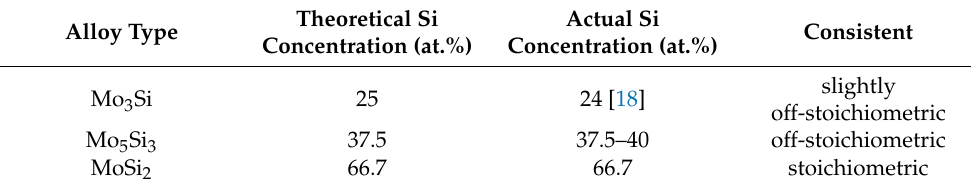
Figure 2. Mo-Si binary phase diagram [15]. Table 3. Mo-Si intermetallic phase crystallography and physical parameters.